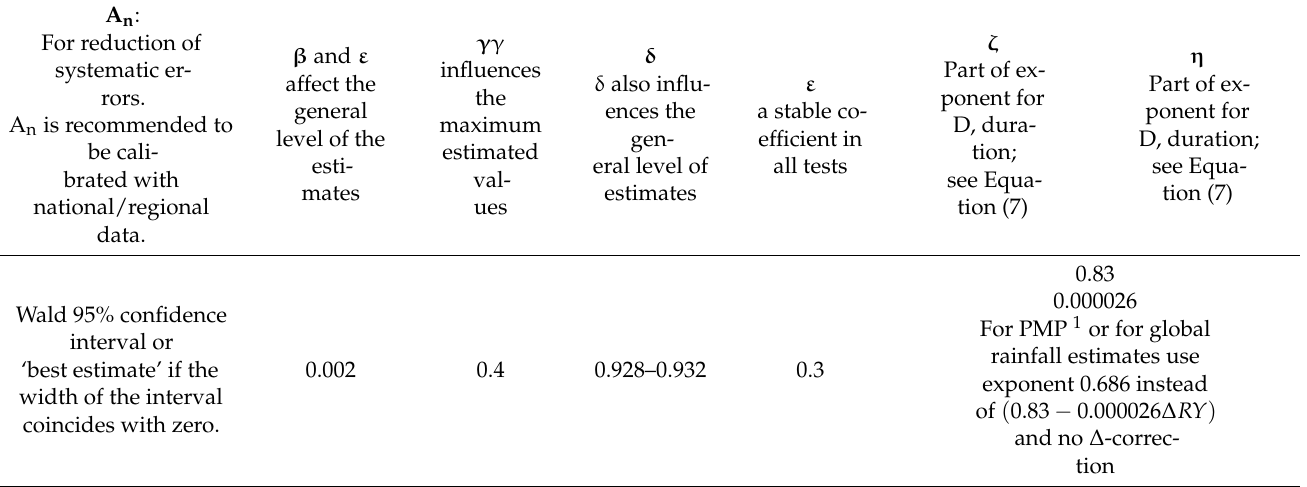
Table 2. Characteristics of the coefficients in the developed relationship R .